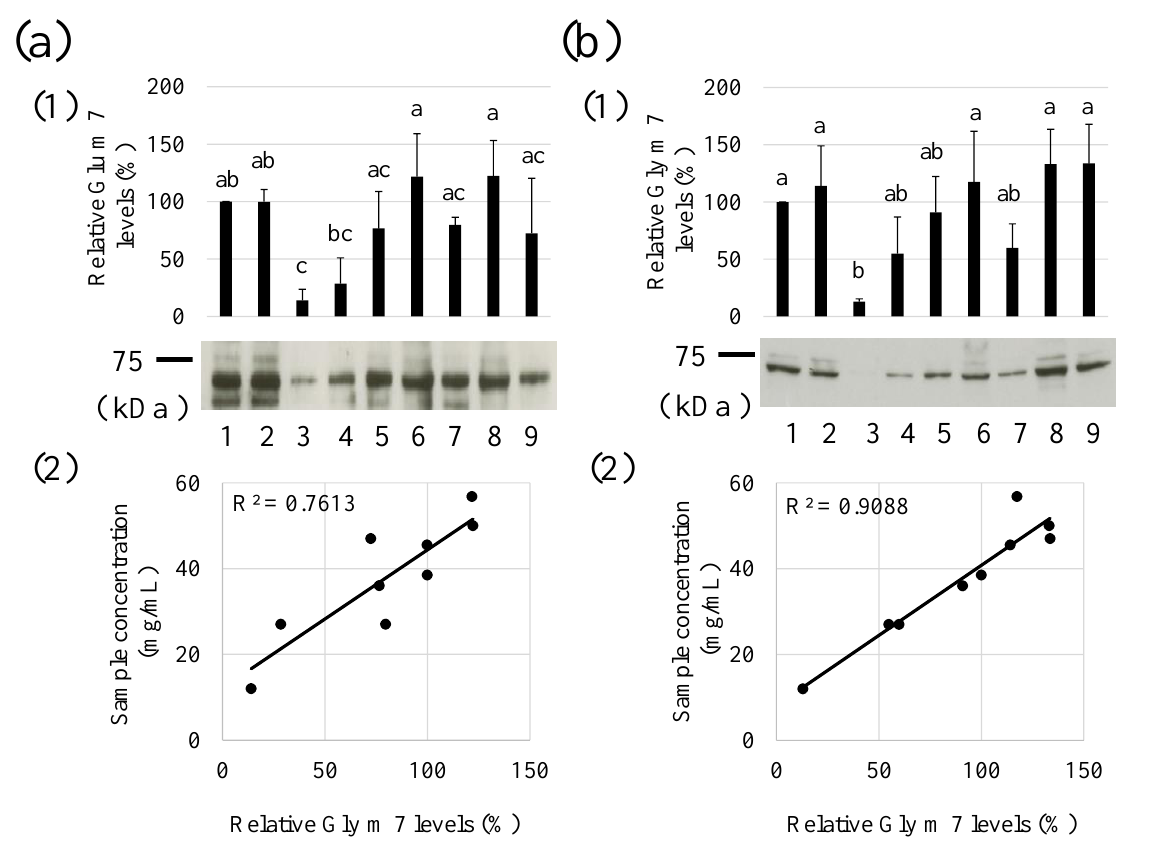
Figure 4. Relative levels of Gly m 7 allergens in various soymilks. Soymilk samples were subjected to sodium dodecyl sulphate–polyacrylamide gel electrophoresis and western blot analysis using anti-Gly m 7 ( a ) or western blot-like analysis using horseradish peroxidase -labeled streptavidin ( b ). Experiments were performed three times, and the data are presented graphically, with bars representing means and error bars representing standard deviation (SD). There are significant differences ( p < 0.05) between different lowercase letters. The representative band images are also shown in ( 1 ). The relations of sample concentrations and relative Gly m 7 levels are indicated in ( 2 ). The relative intensity of Sample 1 was calculated as 100. Sample numbers (1–9) correspond to the sample numbers in Table 1.